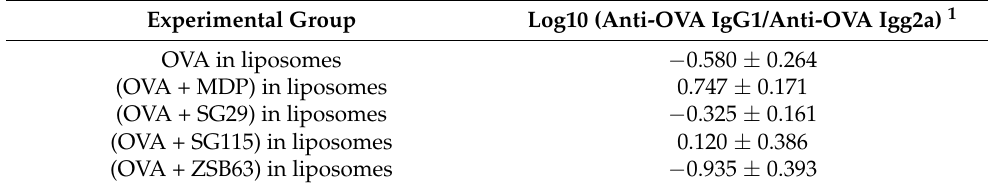
Table 3. The ratio of anti-OVA IgG1 and anti-OVA IgG2a levels following a second booster. Experimental